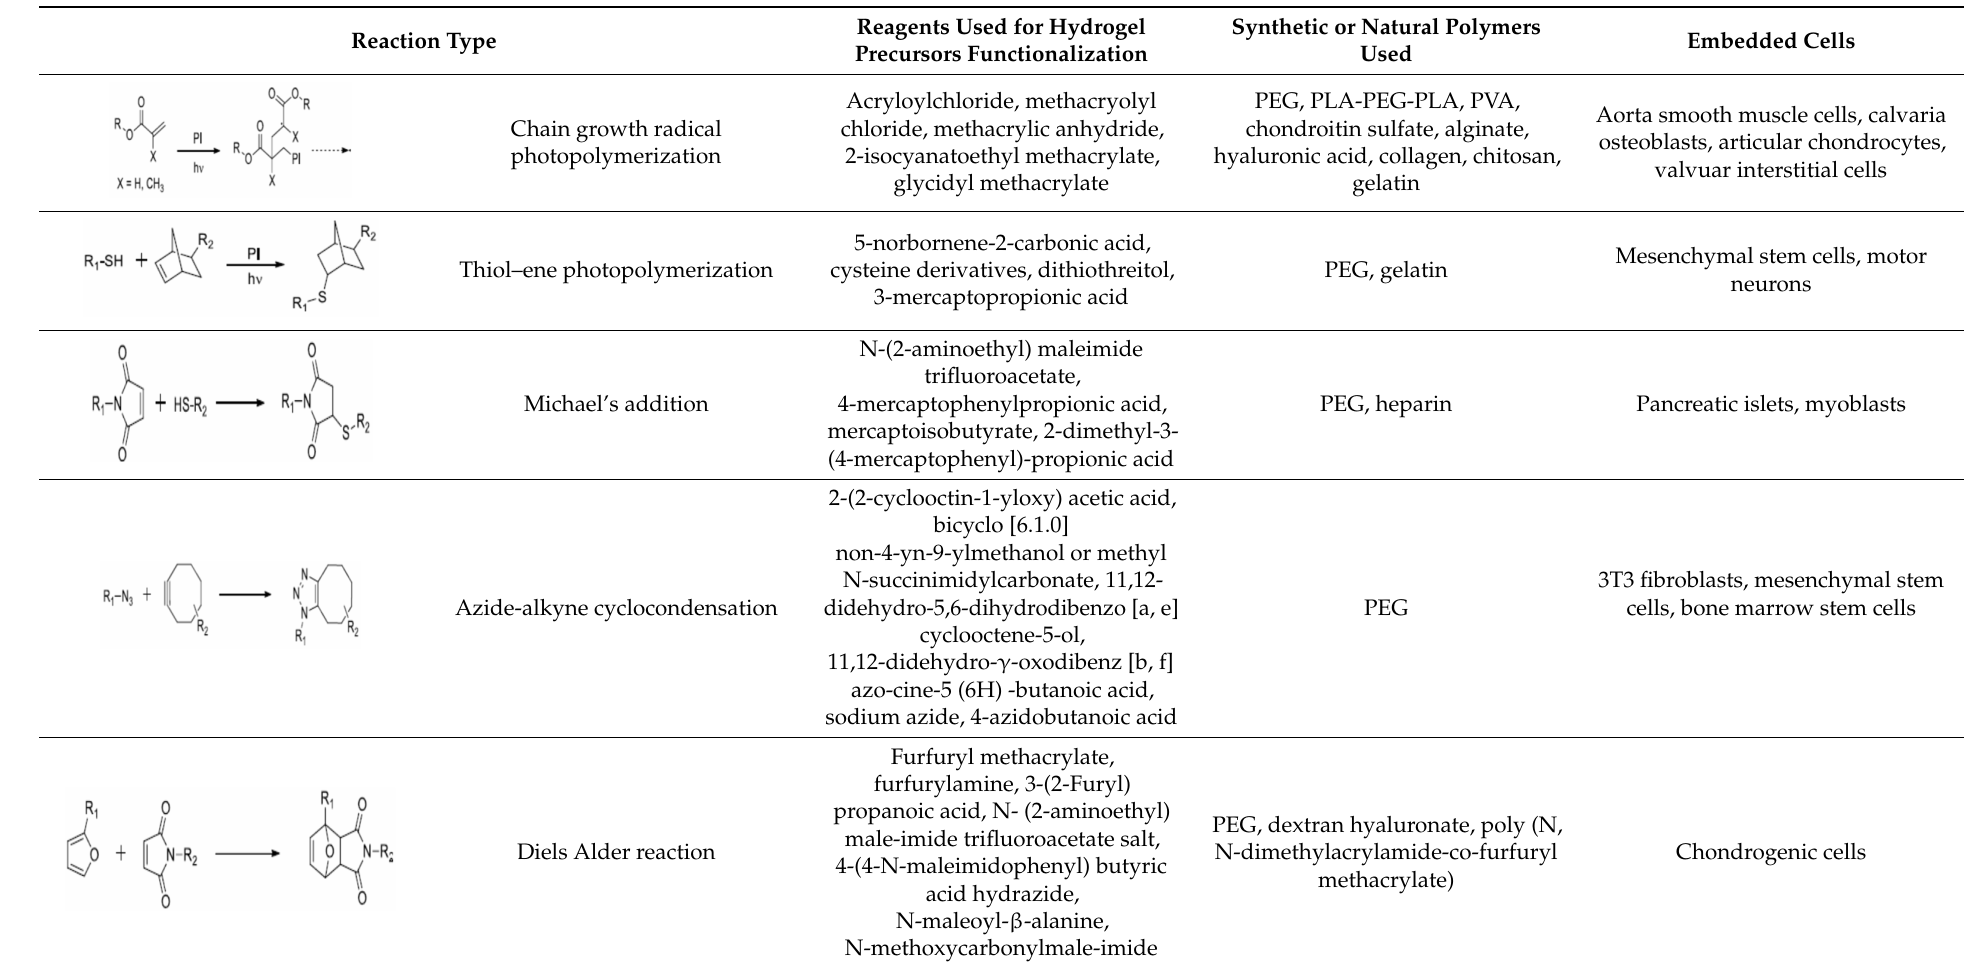
Table 3. Main chemical reactions used for hydrogel polymerization and cell embedding (from C. Echalier et al., 2019